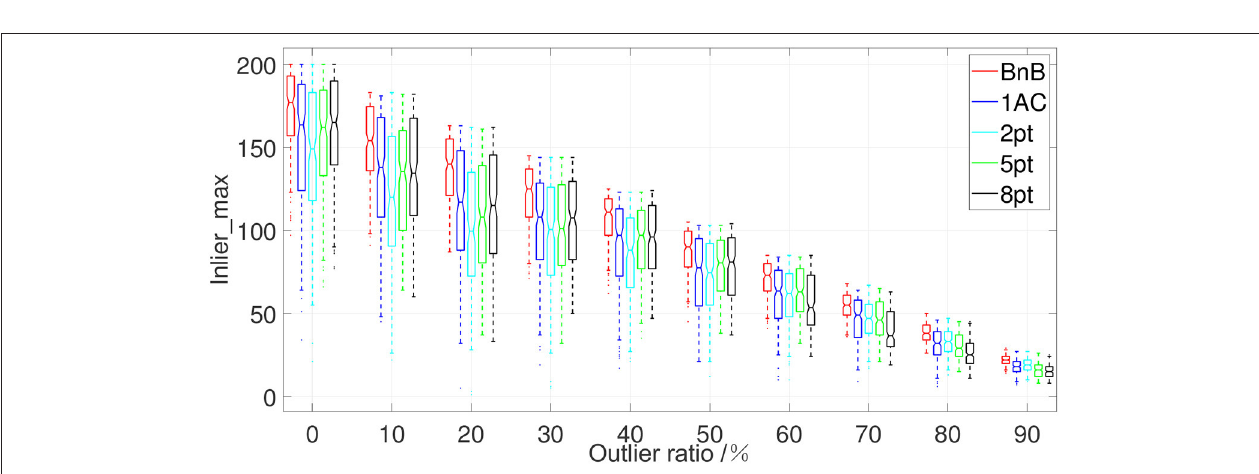
Frontiers in Neurorobotics |